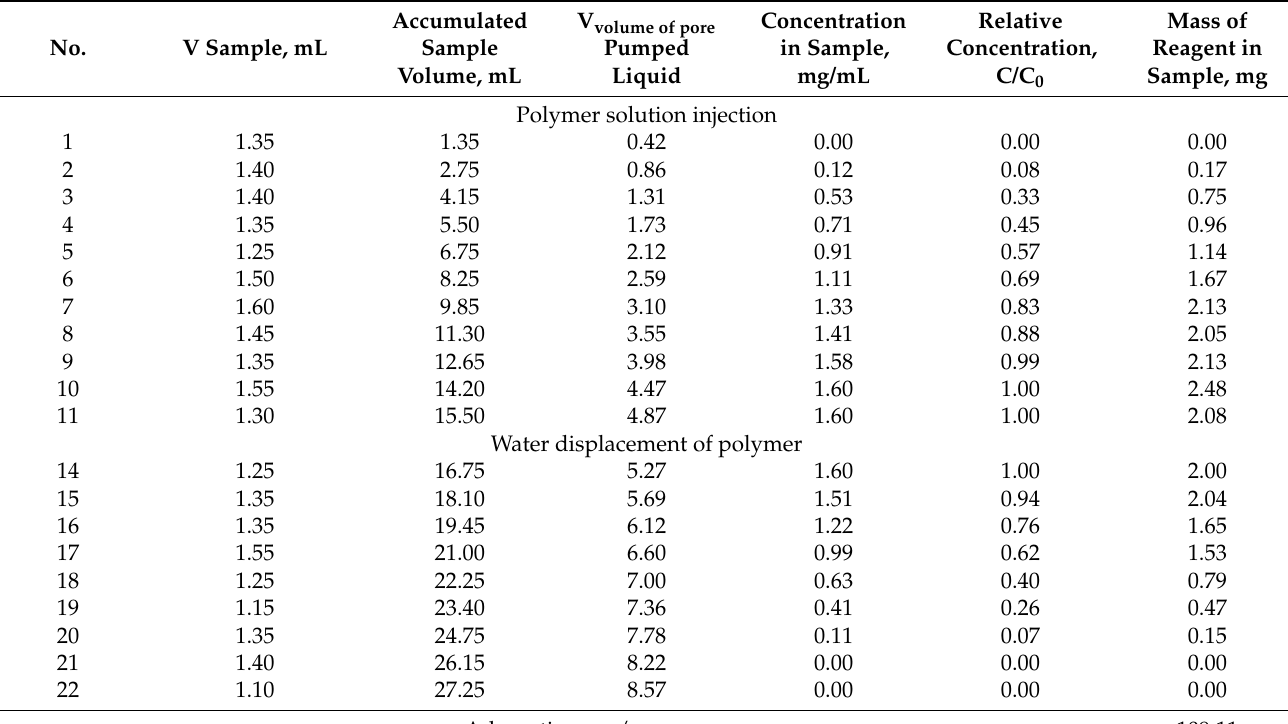
Table 6. Basic fixable parameters in determining dynamic adsorption for a polymer.